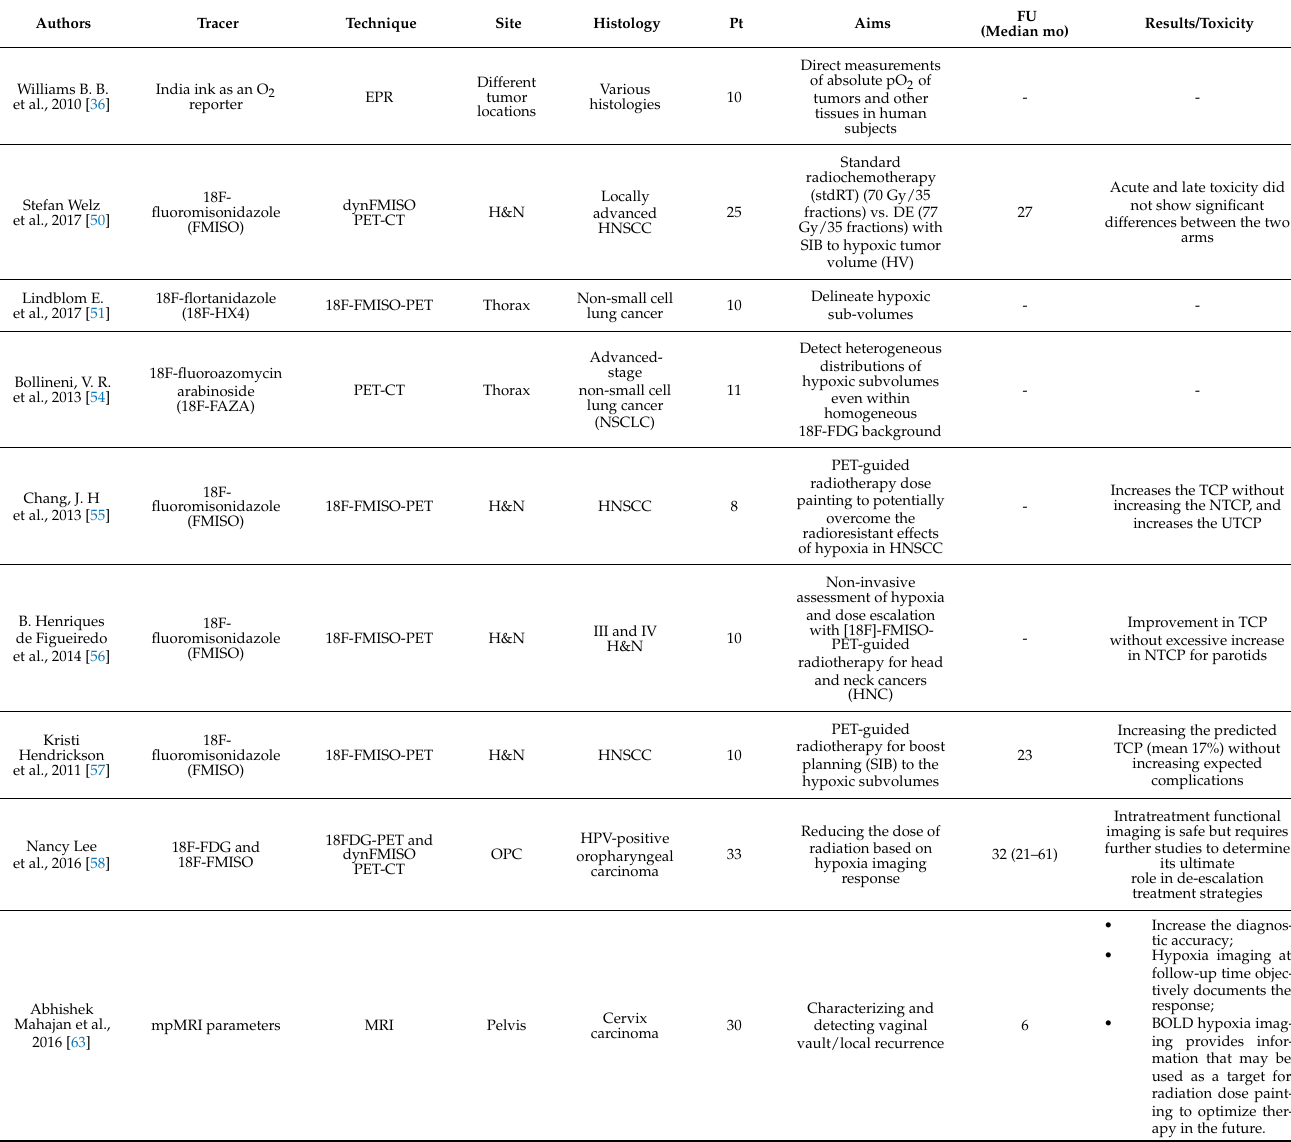
Table 2. Clinical experiences with OGRT. Pt, number of patients; FU, median follow-up (months); H&N, Head and neck; OPC, oropharyngeal cancer; NSCLC, non-small cell lung cancer; HNSCC, head and neck squamous cell carcinoma; mpMRI, multi parametric magnetic resonance imaging; MRI, magnetic resonance imaging; SIB, simultaneous integrated boost; TCP, tumor control probability, NTCP, normal tissue complication probability; UTCP, uncomplicated tumor control probability; BOLD, blood oxygen level dependent.